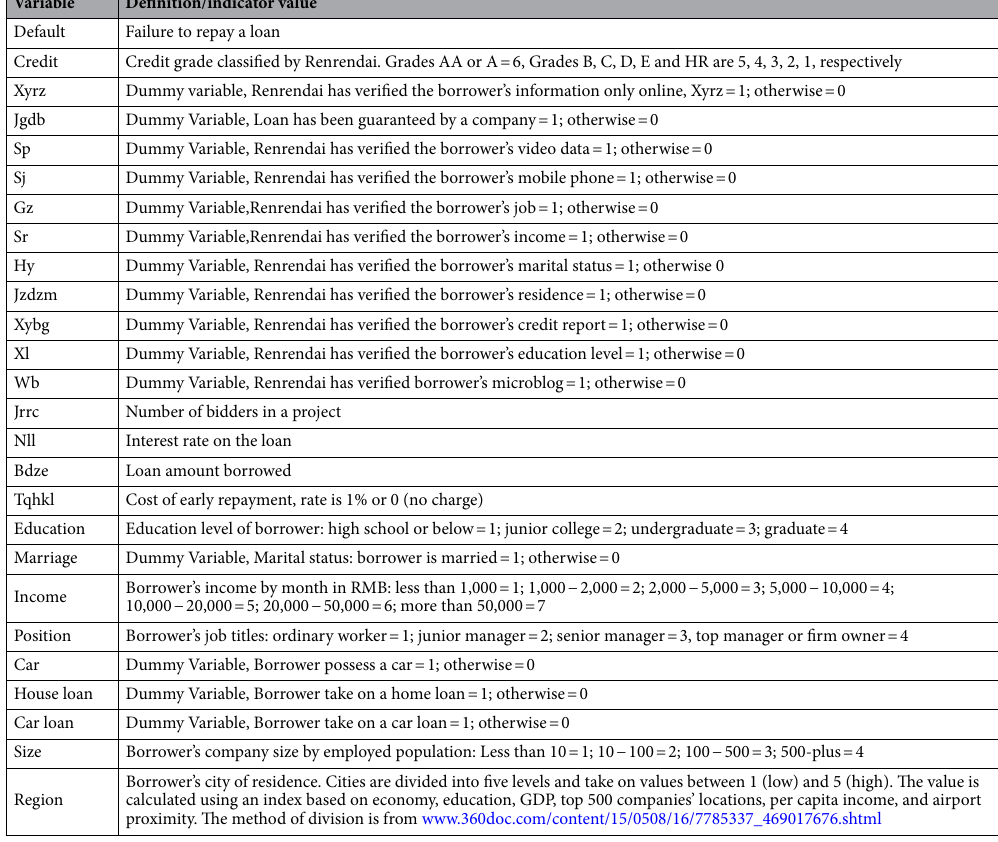
Table 1. Description of the main